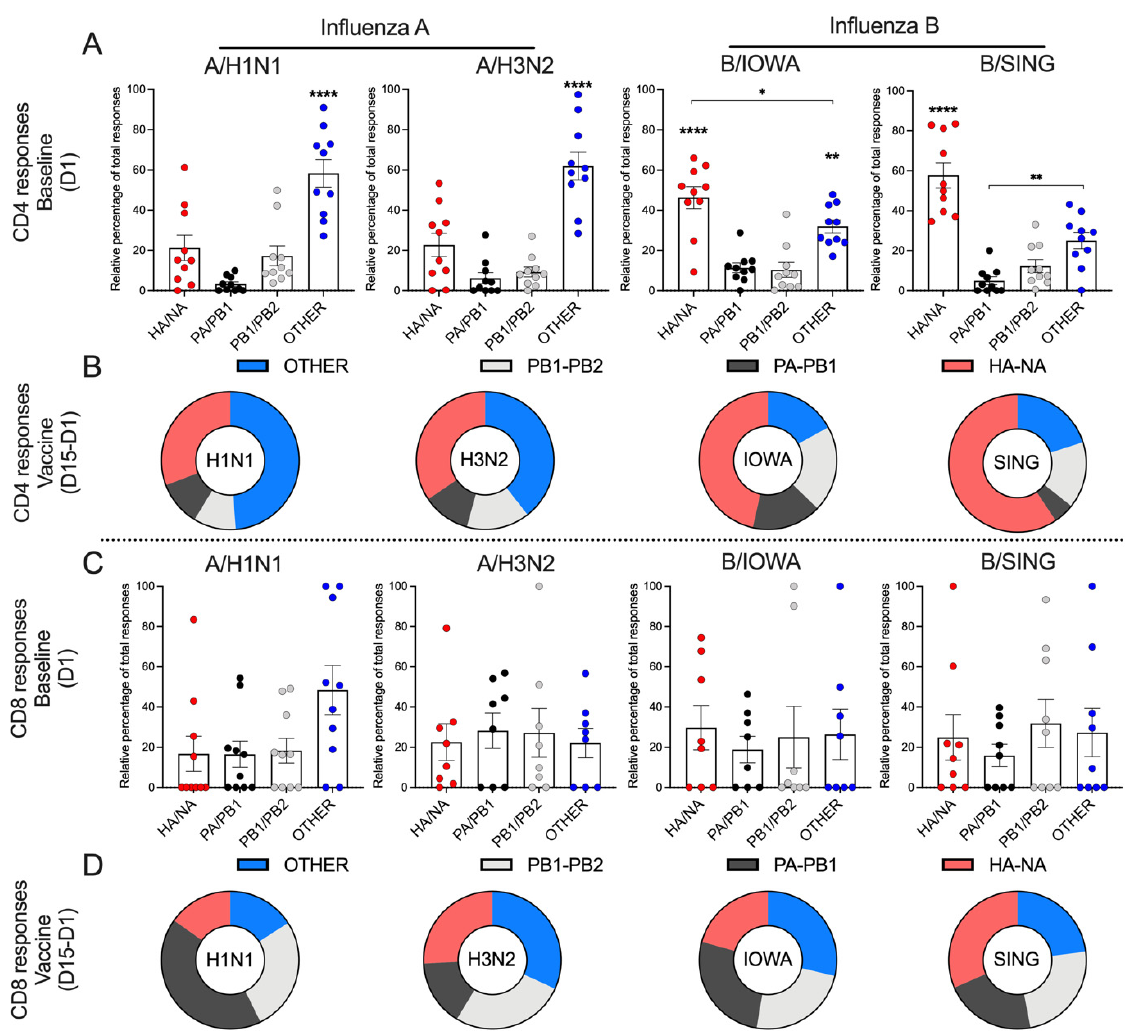
Figure 3. Protein immunodominance of CD4 and CD8 cellular immune responses. ( A , C ) The contributions of 4 major protein components (HA/NA, PA/PB1, PB1/PB2, OTHER–NP/M1/M2/NS1/NEP) of each influenza virus strain to the baseline (D1) CD4 and CD8 responses were summarized ( n = 10). ( B , D ) The relative contributions of 4 major protein components (HA/NA, PA/PB1, PB1/PB2, OTHER–NP/M1/M2/NS1/NEP) of each influenza virus strain to the vaccine-specific (D15–D1) CD4 and CD8 responses were summarized ( n = 10). Vaccine specific T cell responses (D15–D1) were calculated by the CD4/CD8 T cells responses at D15 minus baseline CD4/CD8 responses at D1. ( A , C ) Data were represented by mean ± SEM and were compared with one-way ANOVA adjusted with Tukey’s test for multiple comparisons. **** p < 0.0001, compared with all 3 other groups. ** p < 0.01, * p < 0.05.